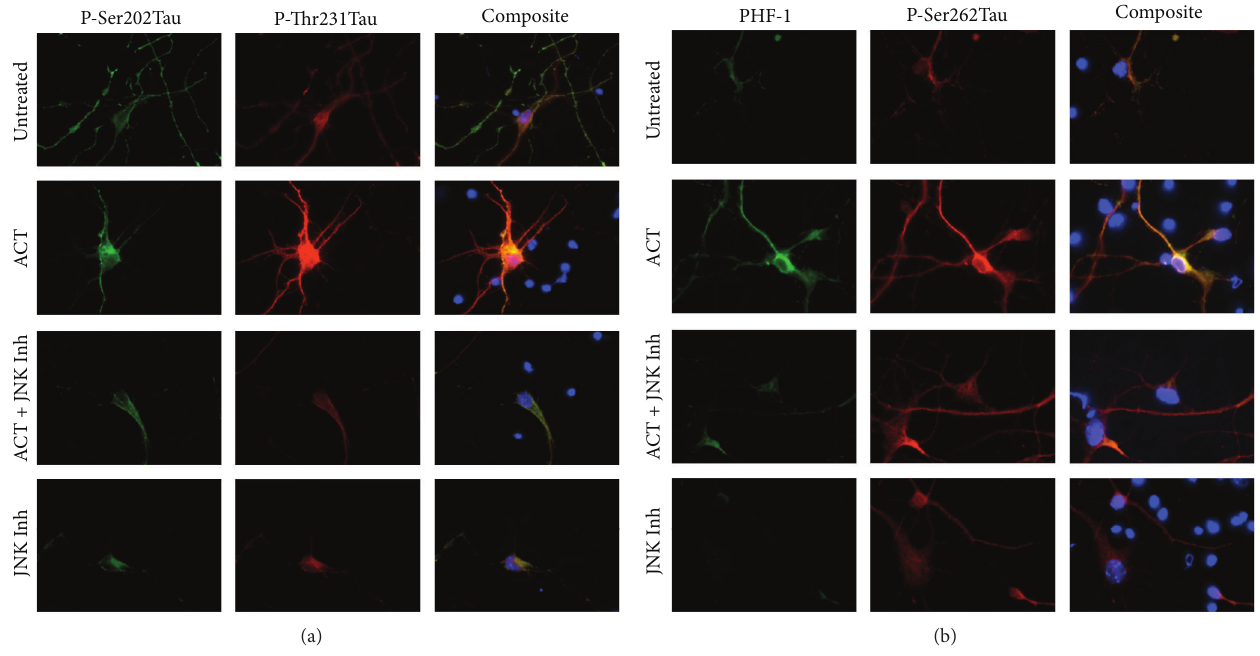
Figure 4: ACT-mediated tau phosphorylation at p-Ser202, p-Thr231, PHF-1, and p-Ser262 in cortical neurons is inhibited by JNK inhibitor: mouse cortical neurons were cultured in 8-chamber slides and preincubated with JNK Inhibitor (10 𝜇 M, 1 hour). The cells were then treated with or without 1mg/mL ACT for 8 hours and probed with (a) p-Ser202 tau monoclonal and p-Thr231 tau polyclonal, (b) PHF-1 tau monoclonal and P-Ser262 tau polyclonal antibodies. Anti-mouse Alexa fluor 488 (green) and anti-rabbit Alexa Flour 594 (red) were used as secondary antibodies, and Hoechst was used to visualize the nuclei. Staining was visualized under a Zeiss fluorescent microscope and analyzed using AxioVision Rel. 4.8